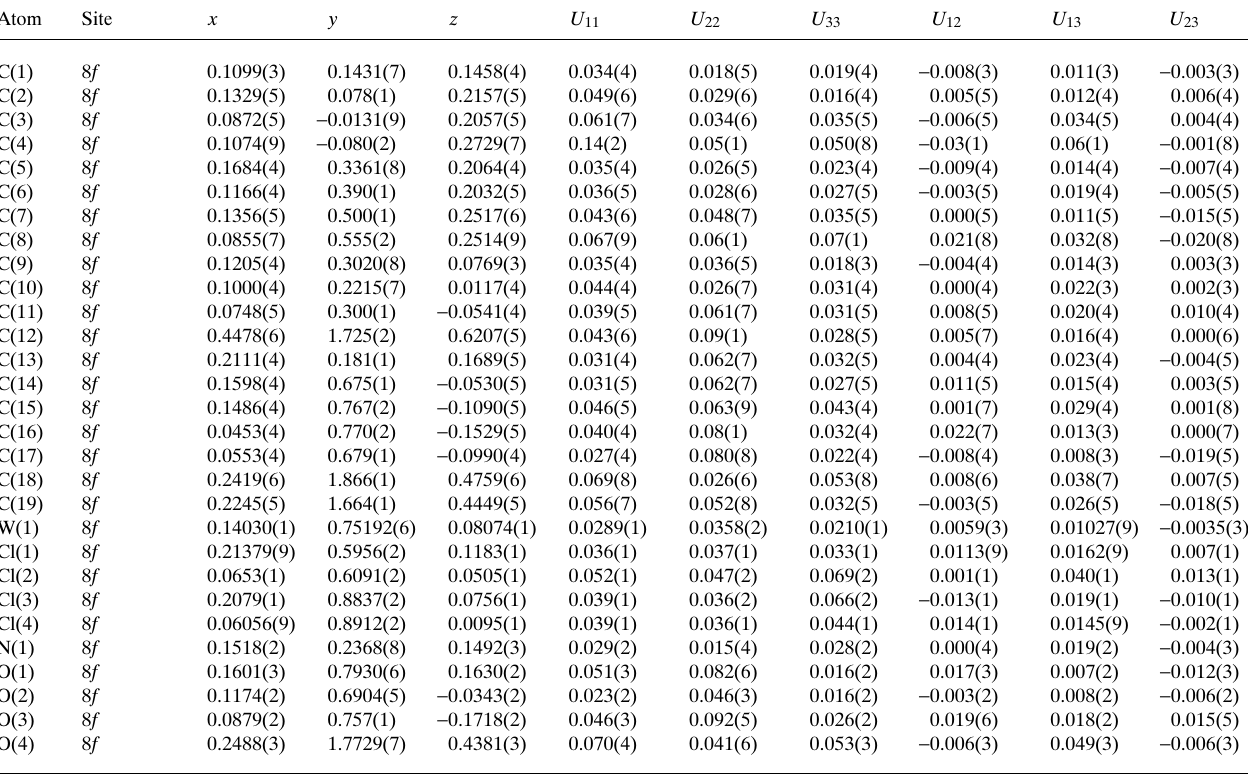
Table 3. Atomic coordinates and displacement parameters (in Å 2 )